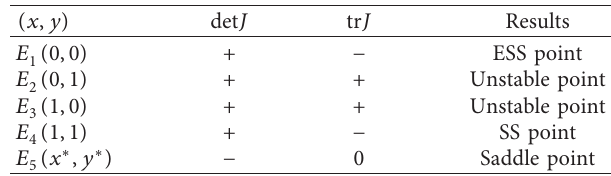
Table 4: The stability analysis of Model II.